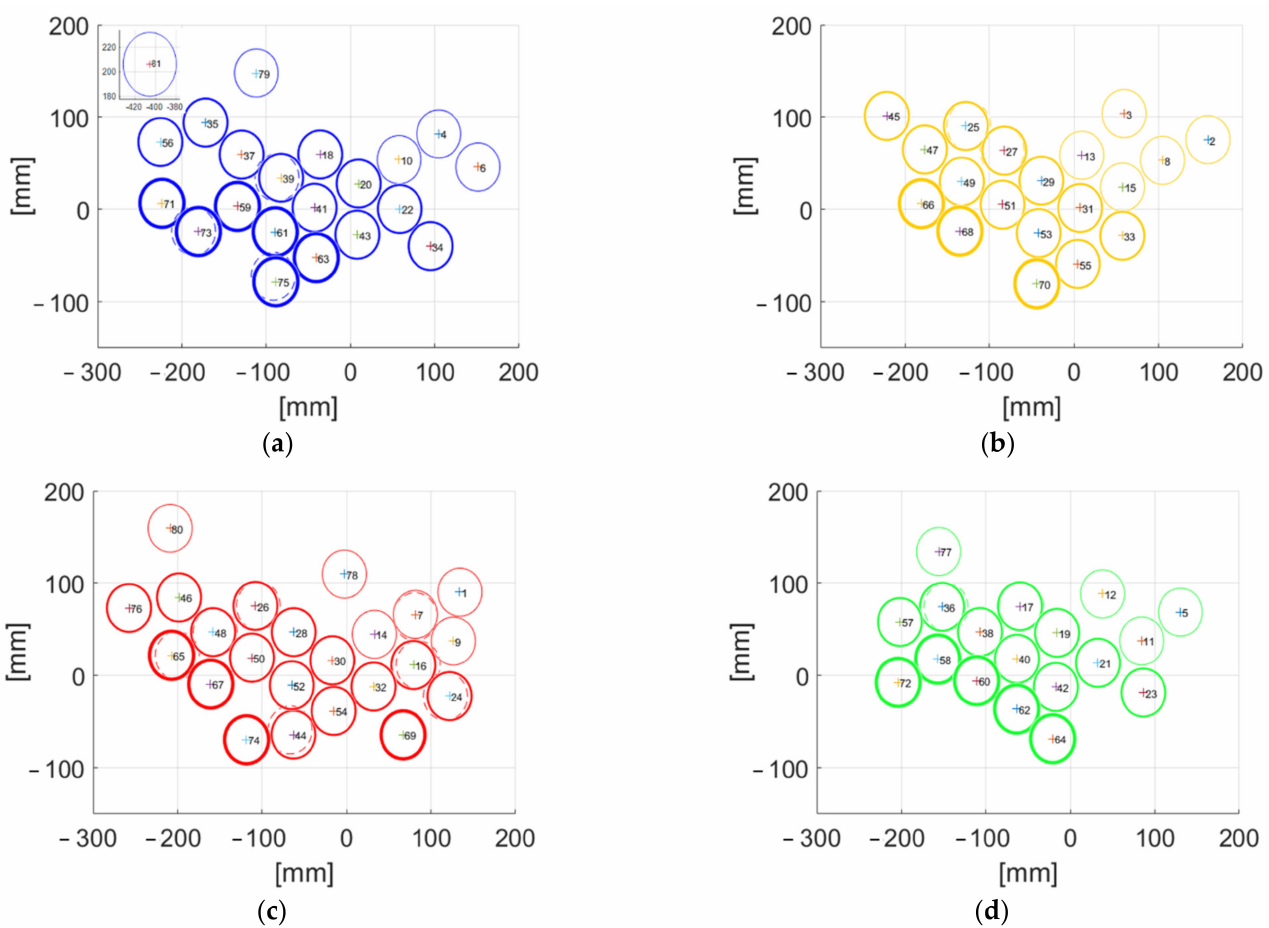
Figure 18. Four colors feed clusters for the four colors scheme. ( a ) Blue, ( b ) yellow, ( c ) red, and ( d )